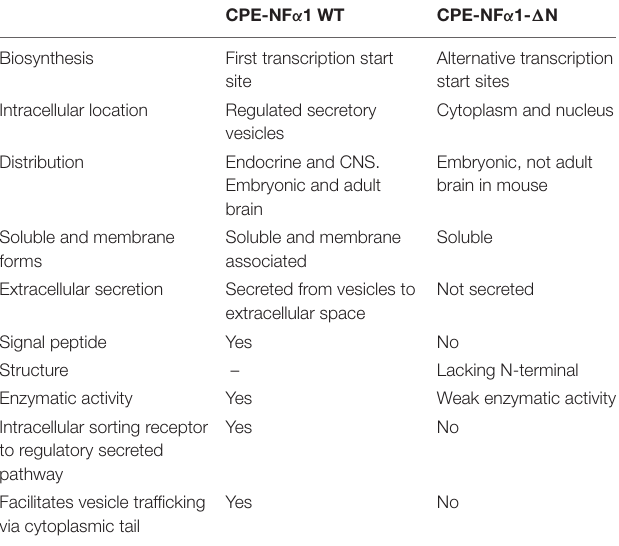
TABLE 1 | Comparison of CPE-NF α 1 WT and CPE-NF α 1- (cid:49)